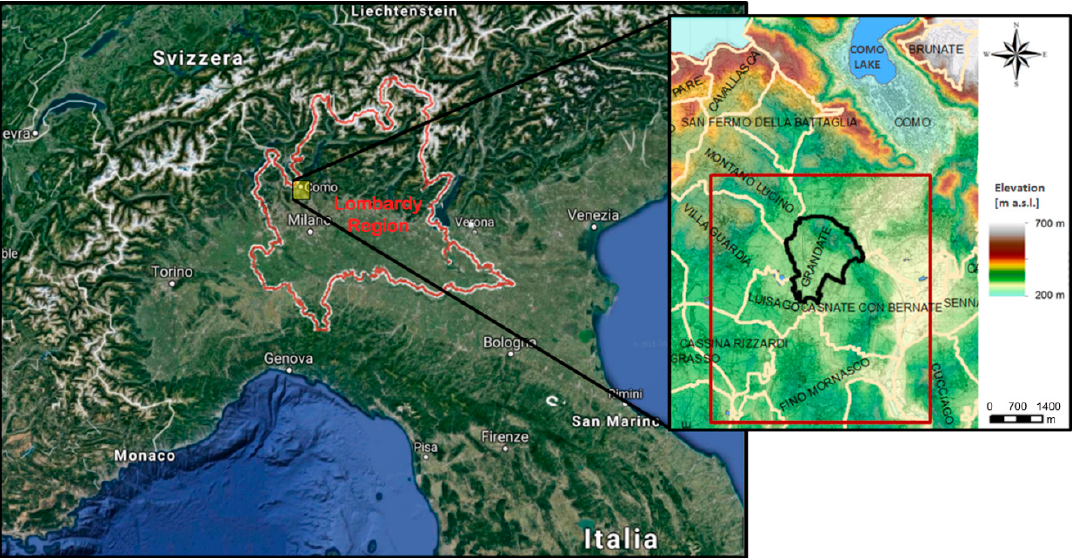
Figure 1. Study area (red square) and the study area’s location; Grandate municipality is contoured in black.